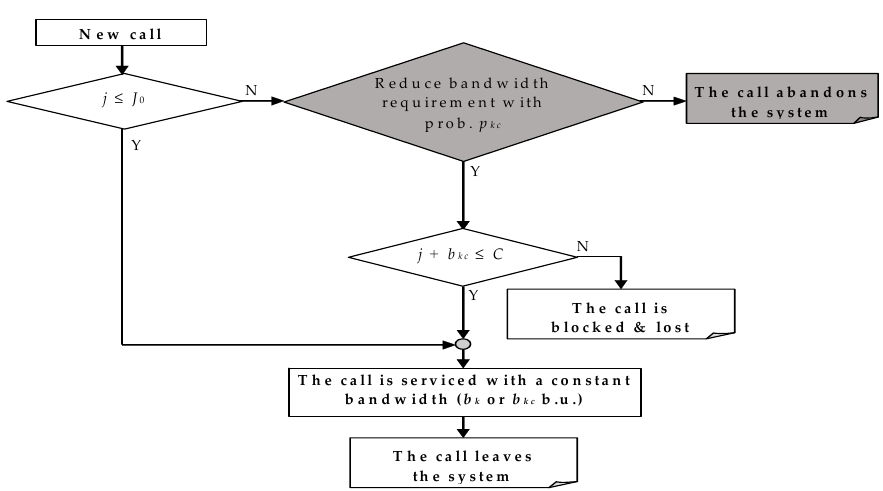
Figure 2. The call admission mechanism for a new call in the probabilistic threshold loss model.